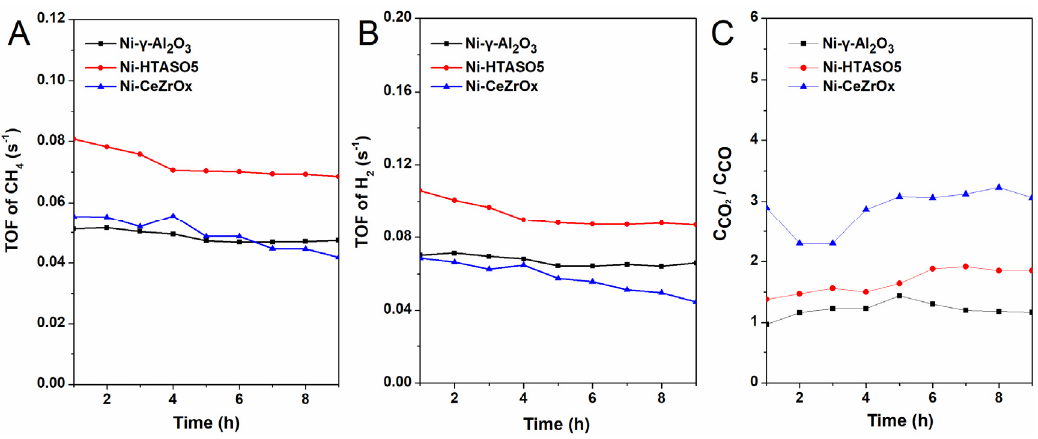
Figure 1. ( A ) Turnover frequency of CH 4 , ( B ) turnover frequency of H 2 and ( C ) the content ratio of CO 2 to CO on Ni ‐γ‐ Al 2 O 3 , Ni ‐ HTASO5 and Ni ‐ CeZrO x catalysts at 600 °C with the mixed flow of H 2 O:CH 4 = 3:1.